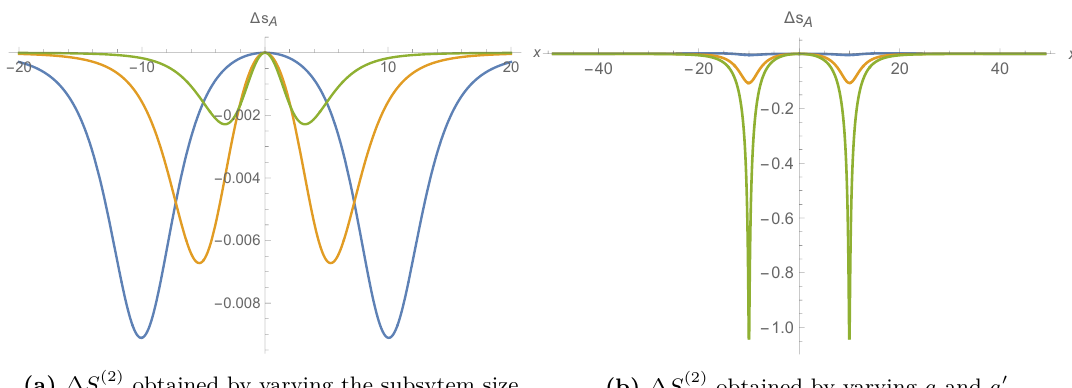
Figure 1. The first plot shows the variation of ∆ S (2) with respect to subsytem size with fixed A UV cutoffs. Blue line: ‘ = 20 , orange line: ‘ = 10 , green line: ‘ = 4 . The second plot shows the variation of ∆ S (2) with respect to UV cutoffs at a fixed subsytem size of ‘ = 20 . Blue line: a = 4 , A a 0 = 6 , orange line: a = 2 , a 0 = 8 , green line: a = 0 . 1 , a 0 = 9 . 9